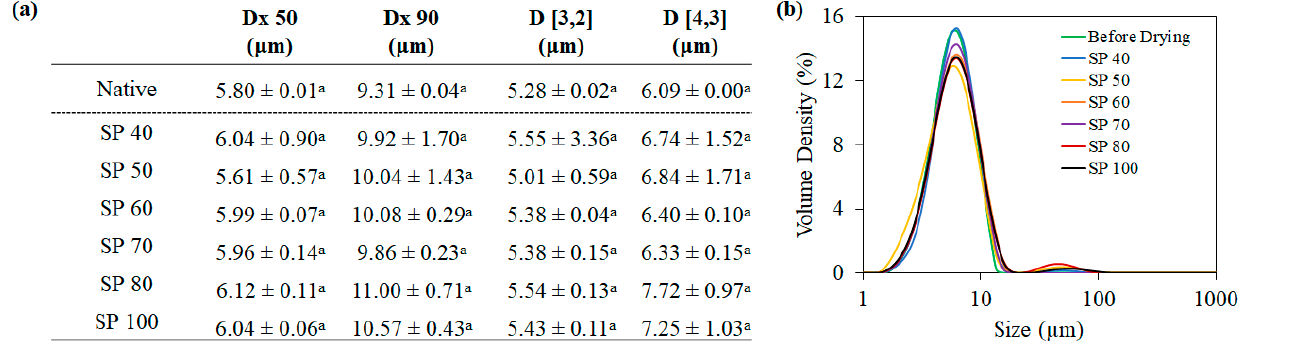
Figure 1. Particle size ( a ) characteristics and ( b ) distribution of native and spray dried waxy rice starches. Values denoted with different alphabets in the same column are significantly different ( p < 0.05).